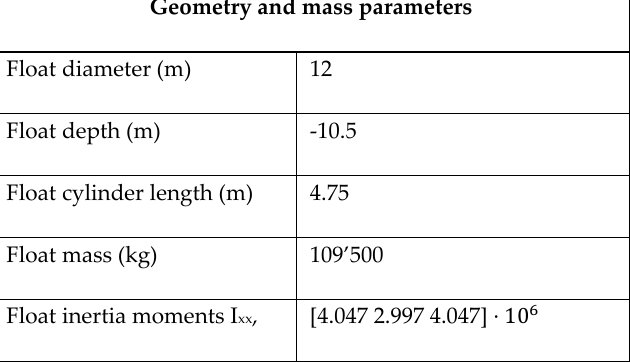
Table 1: Geometry and mass properties of the float and of the